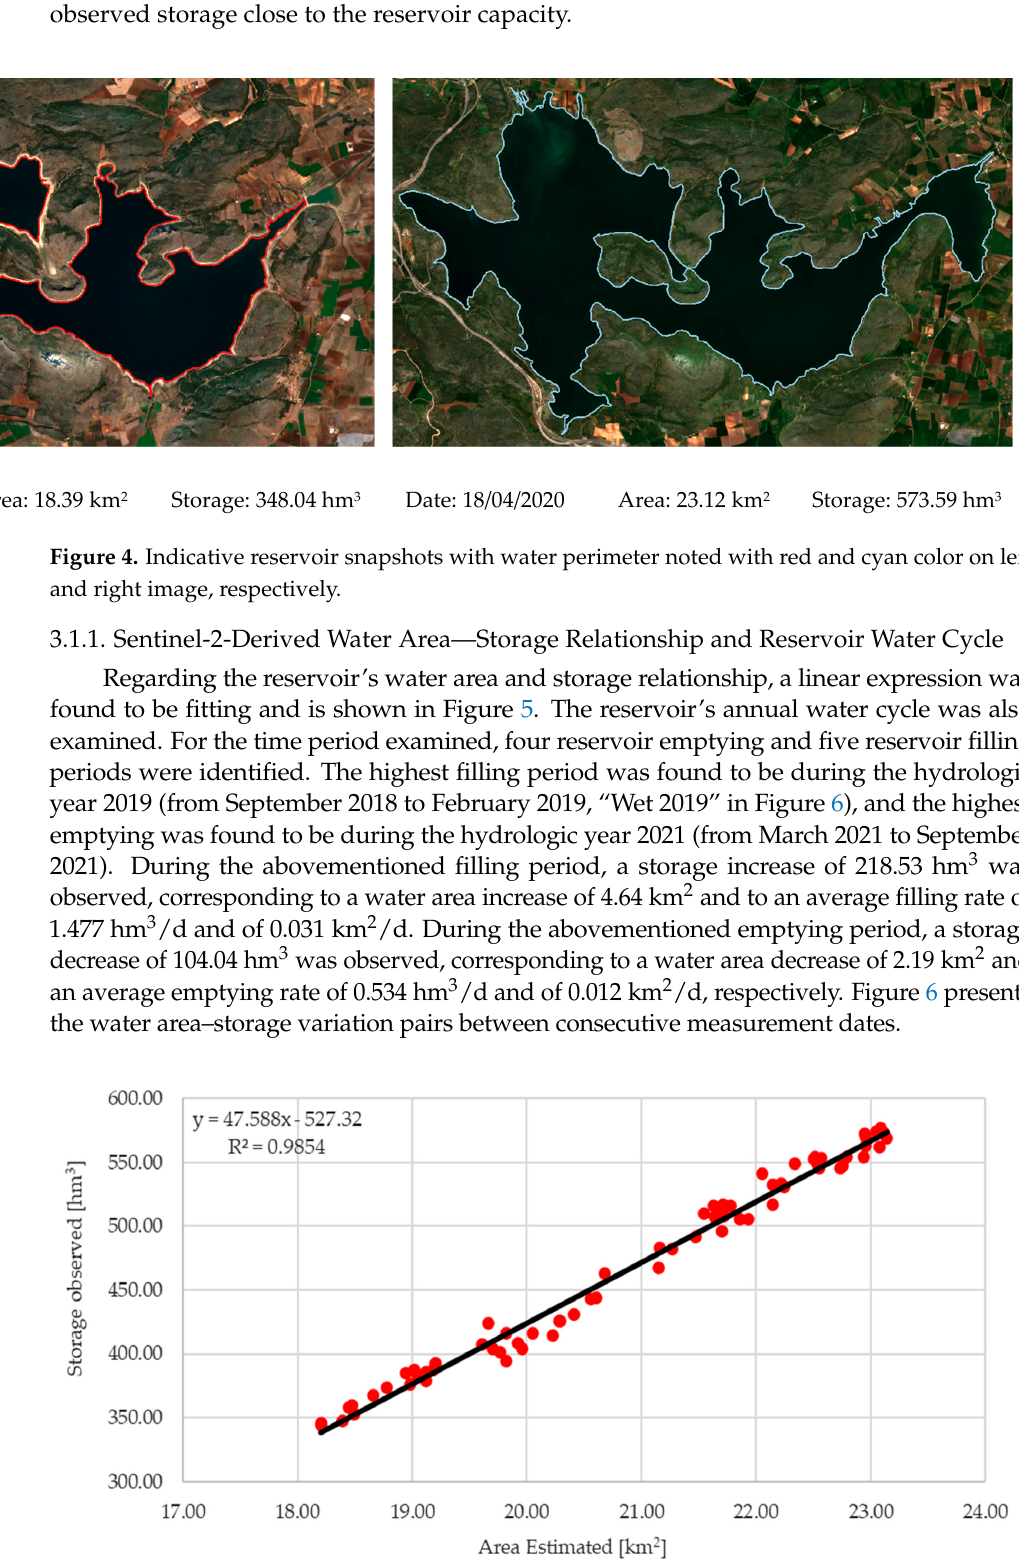
Figure 3. Sentinel-2-derived Yliki reservoir water area and observed storage time series.